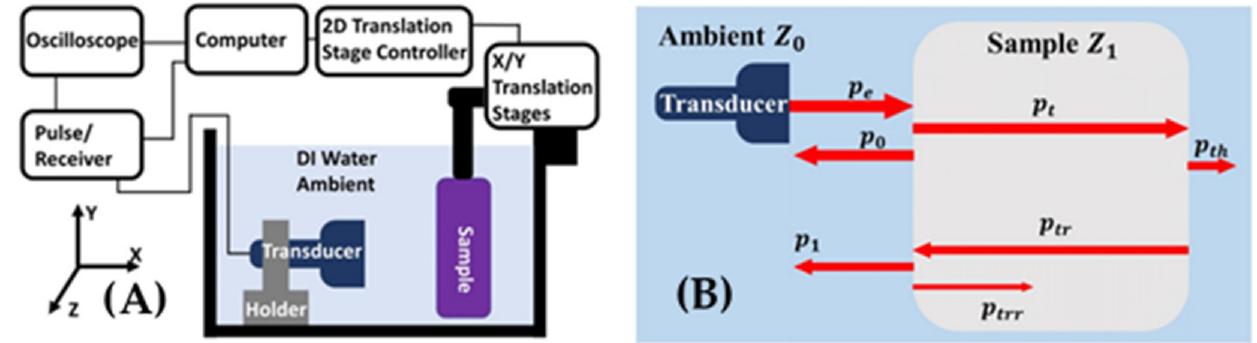
Figure 19. Effective bulk modulus elastography (EBME) technique. ( A ) Experimental set-up of the EBME. ( B ) The principle of EBME is determining the sample acoustic impedance and speed of sound to calculate the effective bulk modulus and effective